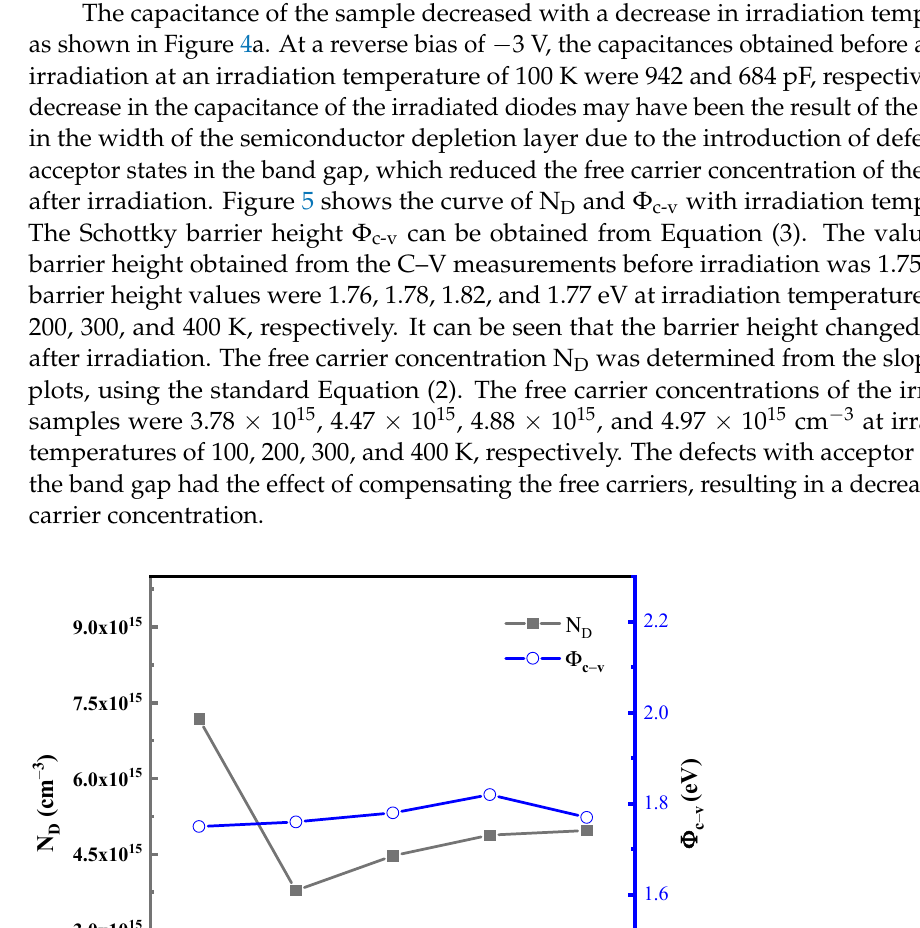
Figure 5. The plot of N D and Φ c-v versus irradiation temperature.